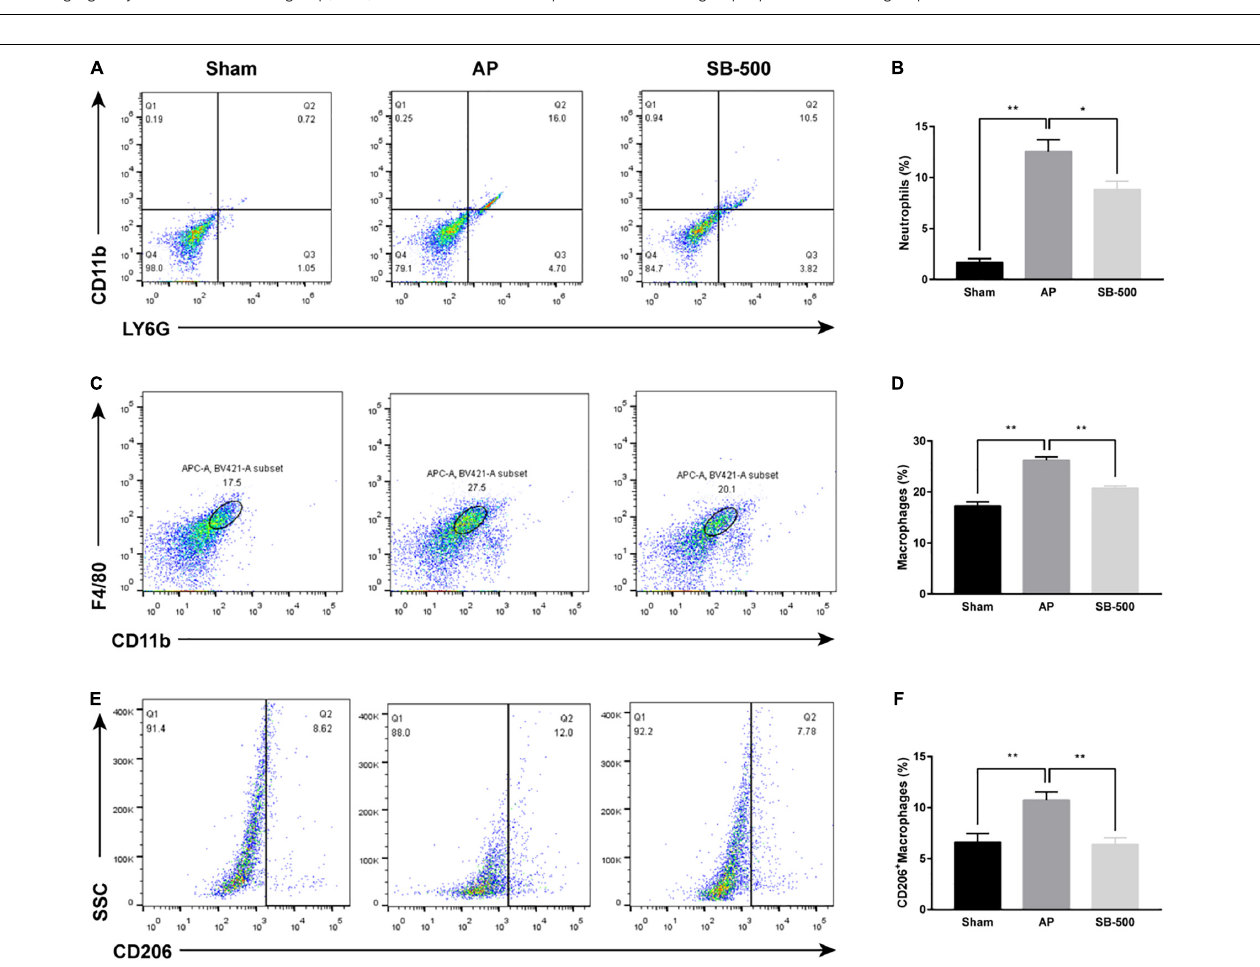
FIGURE 3 | Changes in the proportion of neutrophils, macrophages, and M2 type macrophages in the pancreatic tissue of mice. (A) Neutrophils were labeled with LY6G + CD11b + . (B) Changes in the proportion of LY6G + CD11b + labeled neutrophils in pancreatic tissue of mice in each group. (C) CD11b + F4/80 + was used to label macrophages. (D) Changes in the proportion of CD11b + F4/80 + labeled macrophages in the pancreatic tissue of mice in each group. (E) M2-type macrophages were labeled with CD11b + F4/80 + CD206 + . (F) Changes in the proportion of CD11b + F4/80 + CD206 + labeled M2-type macrophages in pancreatic tissue of mice in each group. n = 6. The data was presented as the mean ± standard error of the mean. * p < 0.05; ** p < 0.01. Sham, Sham operation group; AP, acute pancreatitis group; SB-500, 500 mg/kg butyric acid intervention group.